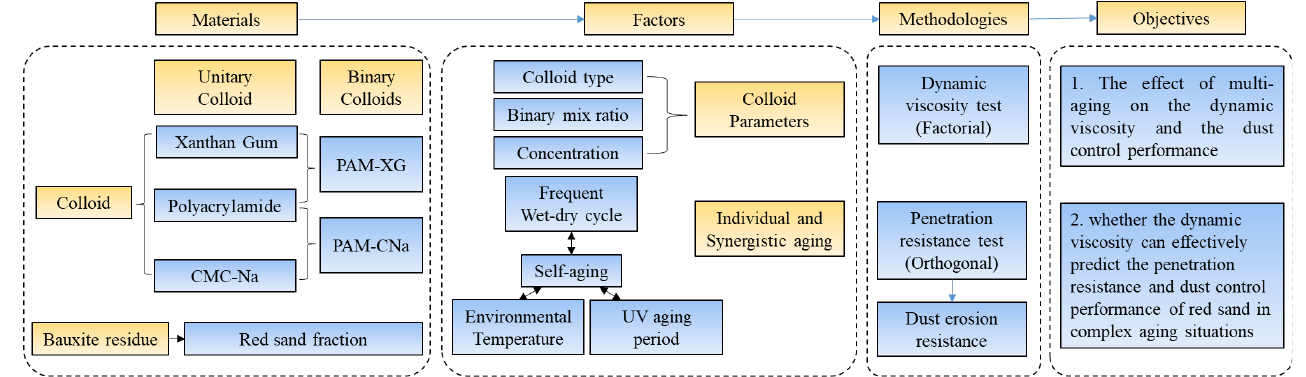
Figure 2. Experiment flowchart and methodology.